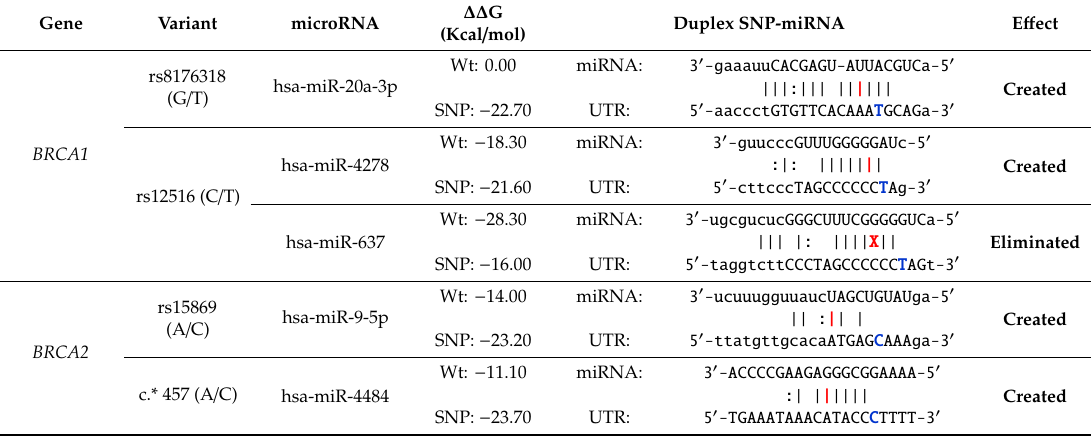
Table 5. In silico e ff ect of allelic variants on the miRNAs-binding seed regions. Some SNPs modified the sequence regions of the mRNA causing the deletion or creation of miRNA binding sites. Red line indicates a new miRNA binding site created; red cross indicates that a miRNA binding site were deleted.